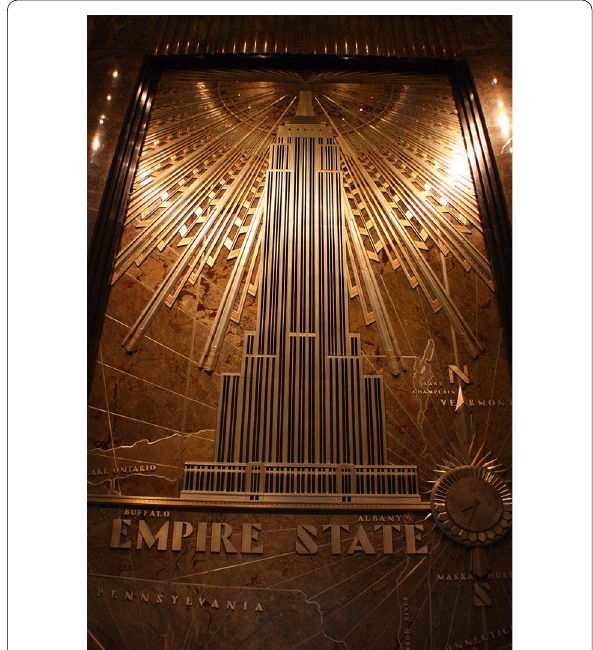
Fig. 18 In the lobby and inside, the Empire State Building in New York represents itself